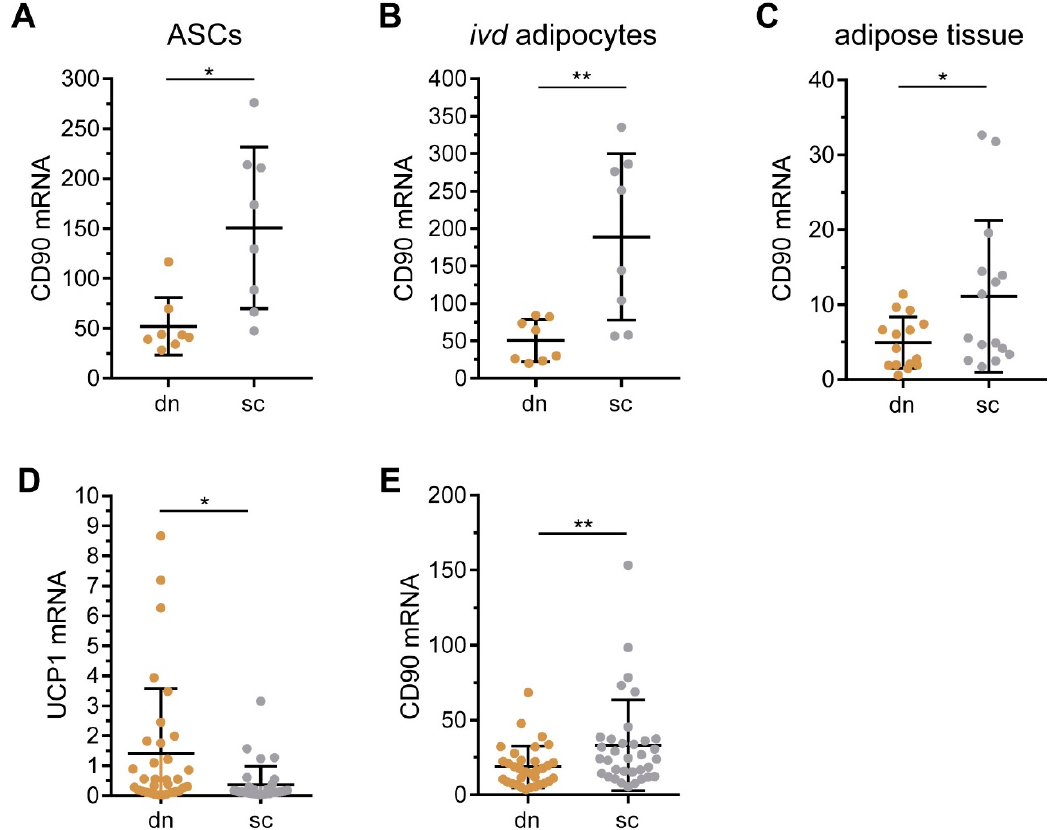
Figure 1. CD90 expression is enriched in scAT and scAT-derived cells compared to dnAT and dnAT-derived cells. ( A–C ) Paired adipose tissue samples derived from the deep neck (dn) and subcutaneous (sc) regions was obtained in a previous study [15]. The mRNA expression of CD90 was determined by RT-qPCR in ( A ) 8 independent adipose tissue stromal cells (ASC) samples, ( B ) 8 corresponding in vitro differentiated adipocyte samples, and ( C ) 15 independent whole tissue samples. TF2B expression was used to normalize the data. Data are displayed as mean ± SD. * p < 0.05, ** p < 0.01, Student’s paired t -test. ( D,E ) Paired adipose tissue samples were derived from the deep neck (dn) and subcutaneous (sc) regions of another 33 patients undergoing neck surgery. The mRNA expression of ( D ) UCP1 and ( E ) CD90 was determined by RT-qPCR. HPRT expression was used to normalize the data. Data are displayed as mean ± SD. * p < 0.05, ** p < 0.01, Student’s paired t -test.